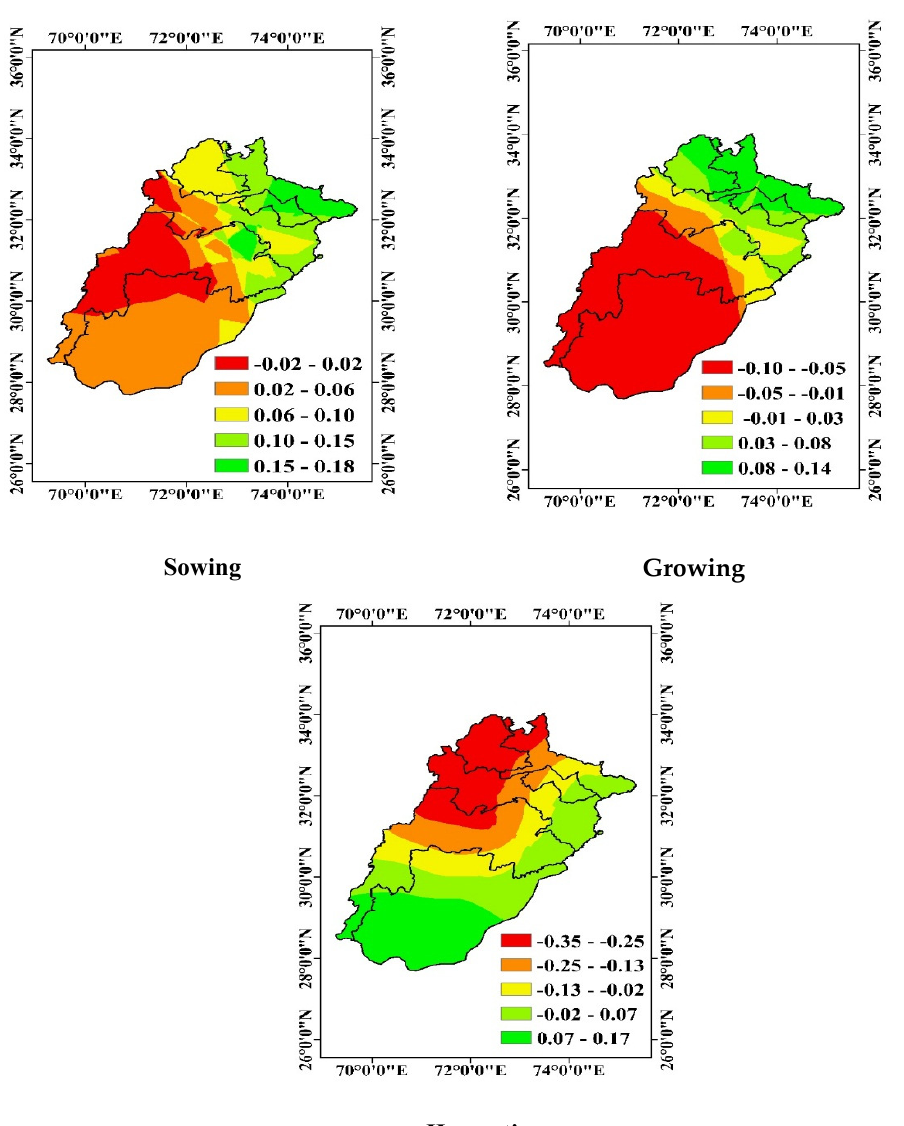
Figure 7. Spatial correlation between soil moisture at different cropping stages and the Standardized Yield Residual Series ( SYRS ) of wheat over the study domain during 2001–2019.